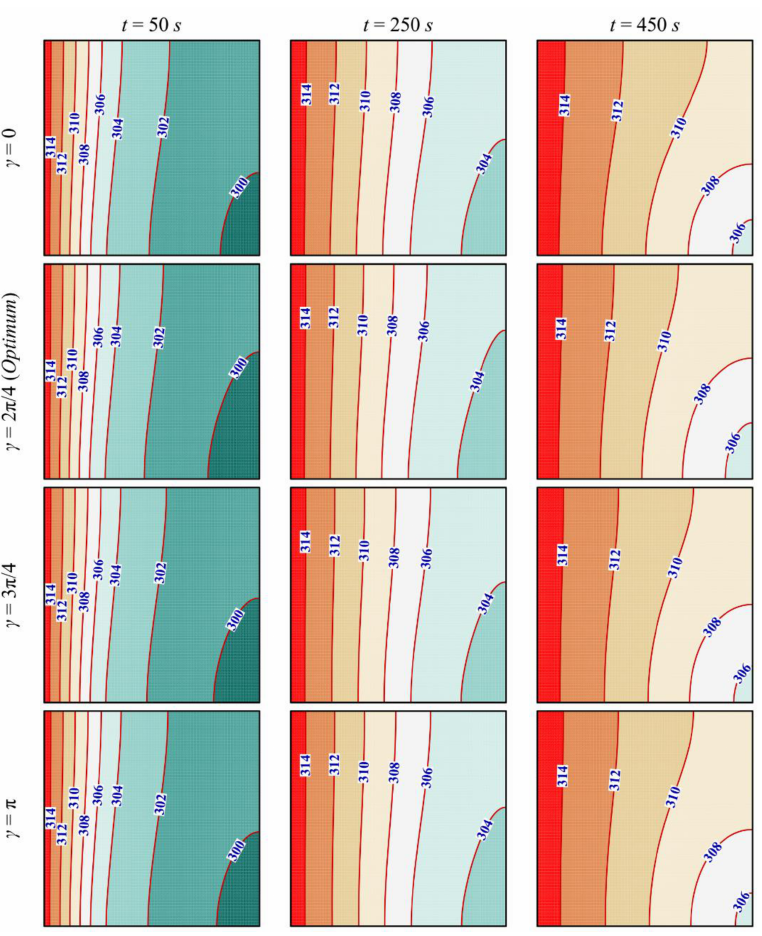
Figure 12. Isotherm contours at three different times for various inclination angles of the enclosed medium when VF na = 0.01, ε = 0.800, a = − 2, and PPI = 25.